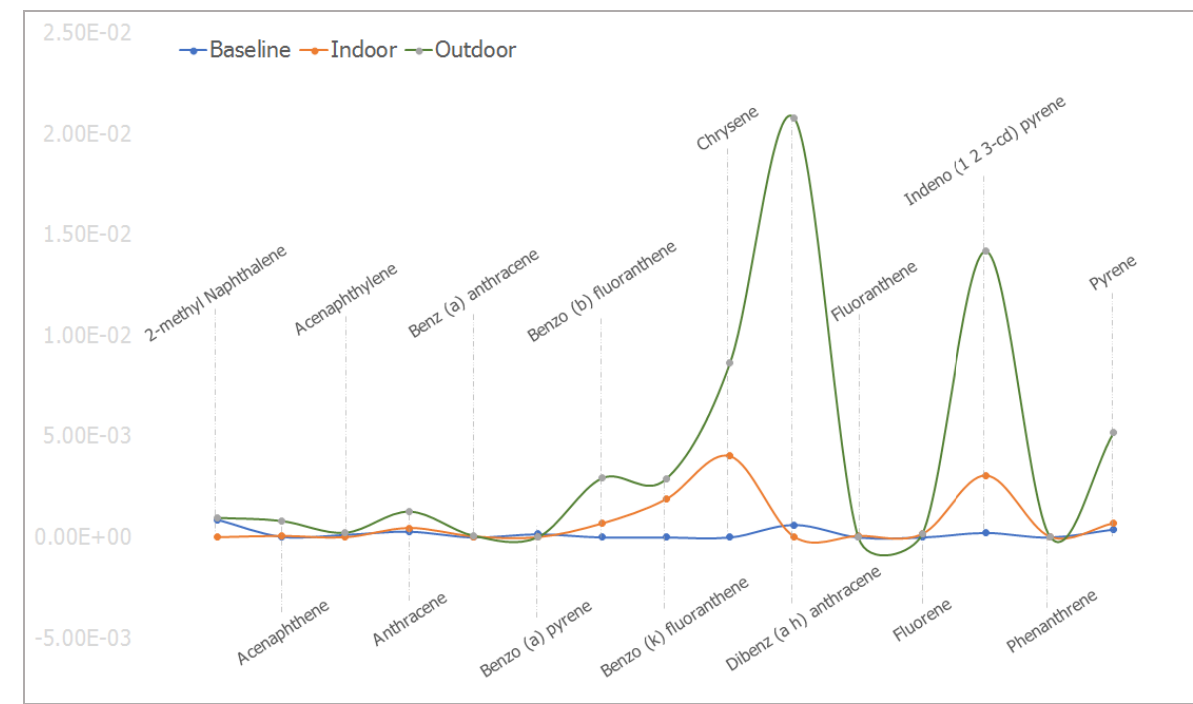
Figure 3. The mean concentrations (in ppm) for the individual PAHs in baseline, indoor, and outdoor experimental animal groups.